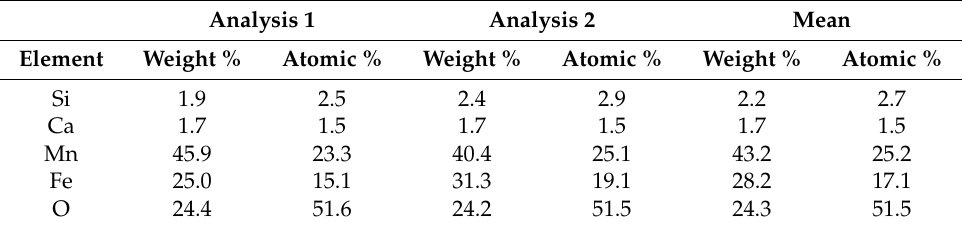
Figure 14. SEM radial views of Miocene wood mineralized with Mn-Fe, Virgin Valley, Nevada USA, specimen in Figure 7C. ( A , B ) Tracheids mineralization showing flake-like morphology; ( C, D ) tracheids mineralized with blocky mineral particles.